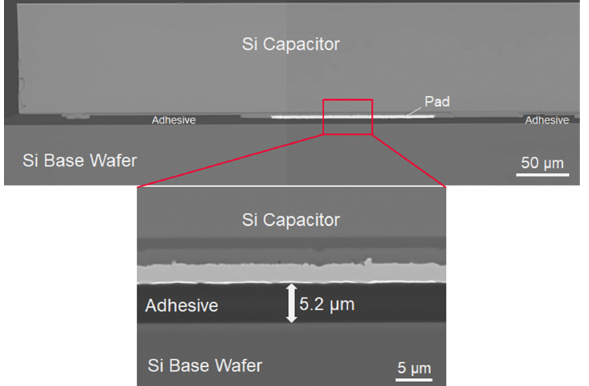
Figure 20. Cross-sectional SEM image of Si capacitor die after die attaching step. No voids at the pad interface are observed.